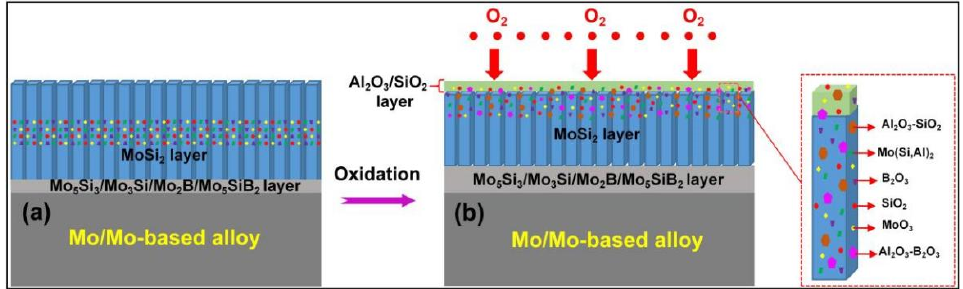
Figure 6. Oxidation mechanism diagram of HAPC coatings on molybdenum and its alloys. ( a ) Initial oxidation stage, ( b ) Late oxidation stage of coating.